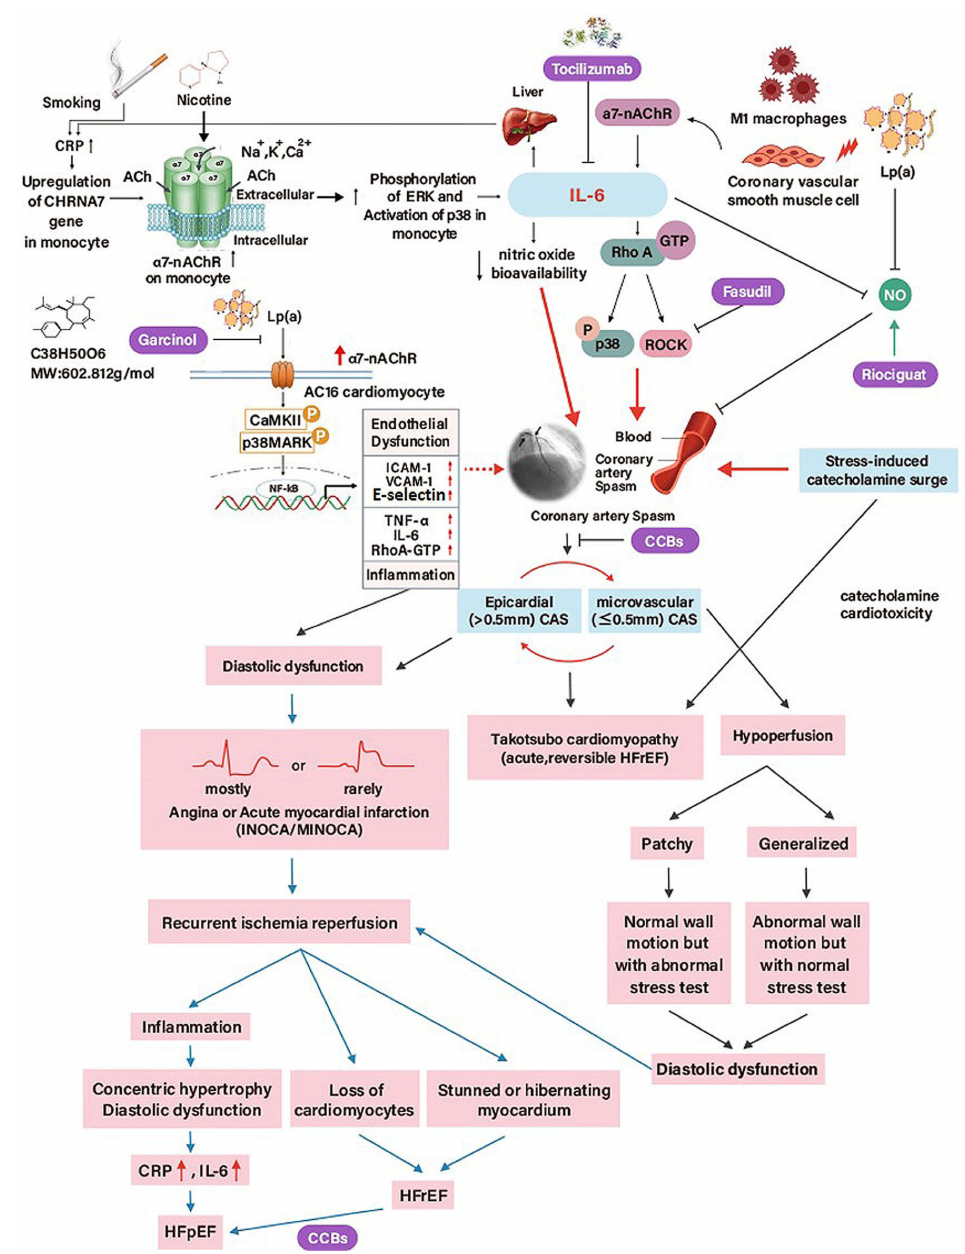
Figure 6. Graphical abstract depicting the multifactorial molecular and cellular mechanisms involved in the initiation and progression of CAS and CAS-related preclinical HF to clinical overt HF. The development of CAS can be contributed to by smoking, CRP, and Lp(a). Fasudil, Tocilizumab, Garcinol, and Riociguat are potential disease-modifying therapies of CAS [196,197,201,252]. The reversible nature of CASHF is suggested and represented by a reciprocal relationship and a positive feedback loop between epicardial and microvascular CAS. Solid arrows: direct activating interac- tions; Dashed arrow: indirect activating interactions; Blunt arrows: inhibition. Ach: acetylcholine; α 7-nAChR: α 7-nicotinic acetylcholine receptor; CHRNA7: α 7-nAChR protein coding gene; CamKII: calmodulin-dependent kinase II; CAS: coronary artery spasm; CRP: C-reactive protein; HFpEF: heart failure with reduced ejection fraction; HFrEF: heart failure with reduced ejection fraction; ICAM-1: in- tercellular adhesion molecule 1; IL-6: Interleukin-6; INOCA: ischemia with non-obstructive coronary artery disease; Lp(a): lipoprotein(a); MINOCA: myocardial infarction with non-obstructive coronary artery disease; p38MAPK: p38 mitogen-activated protein kinase; VCAM-1: vascular cell adhesion molecule